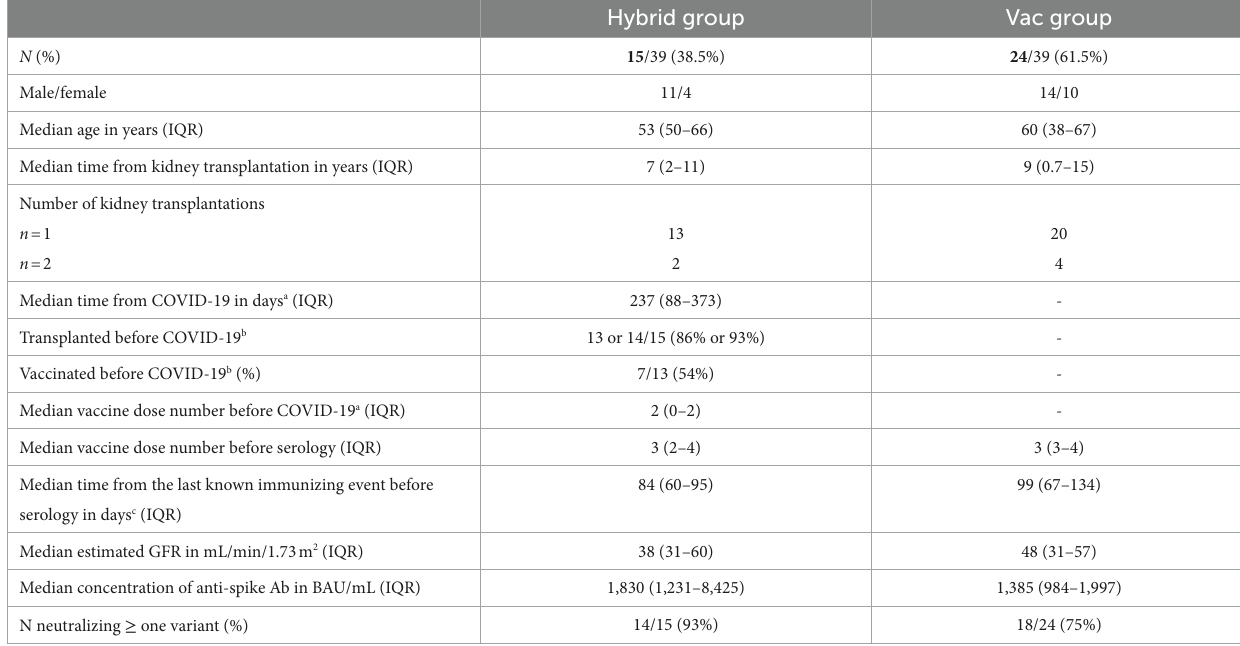
TABLE 3 Characteristics of the Hybrid and Vac groups at the time of